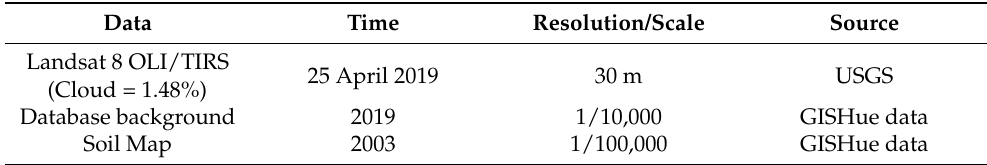
Table 1. Satellite images and GIS data for soil characteristics analysis.